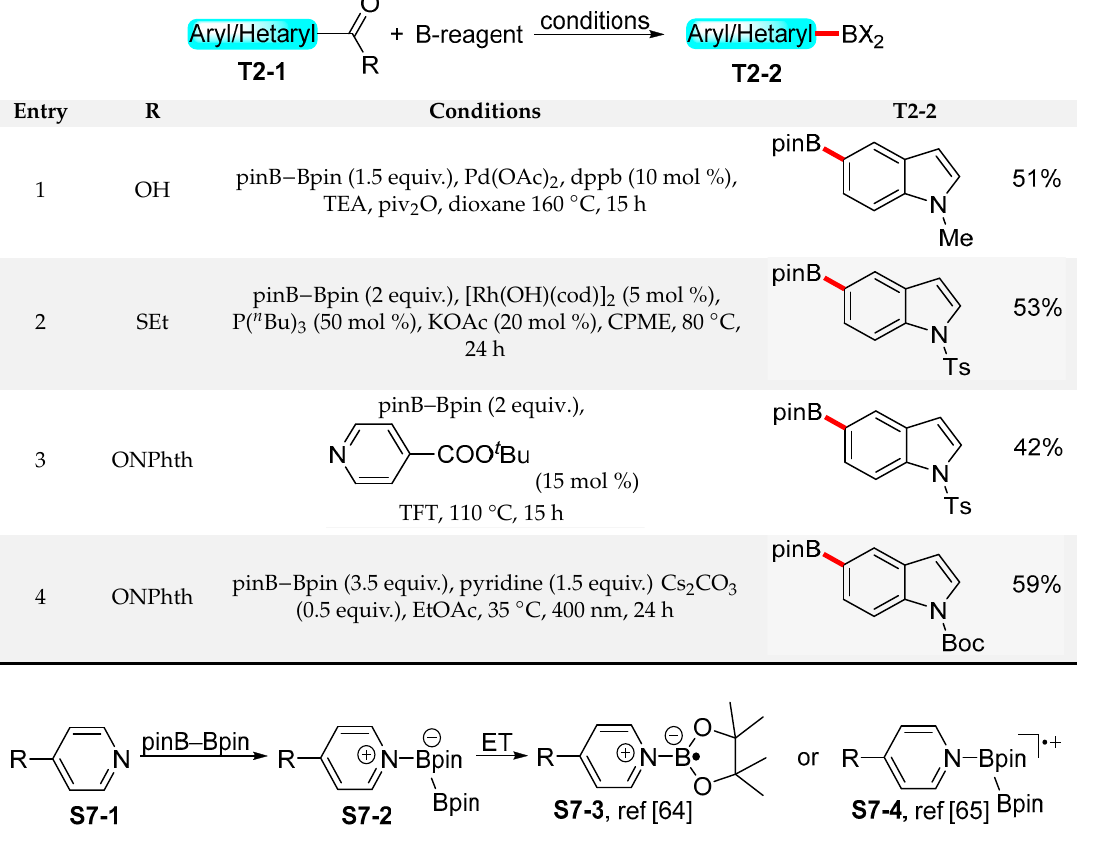
Table 2. Decarboxylative cross-coupling for the synthesis of indolylboronic acids.